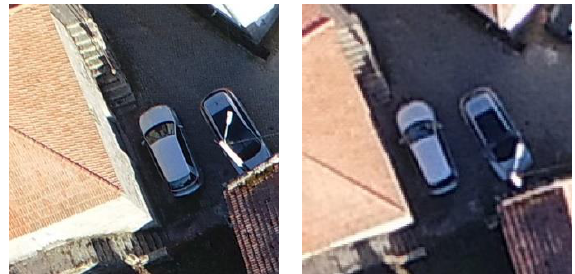
Figure 1. Examples of images acquired from 100 m height, with GSD 3 cm (left) and from 300 m, with GSD 9 cm (right).